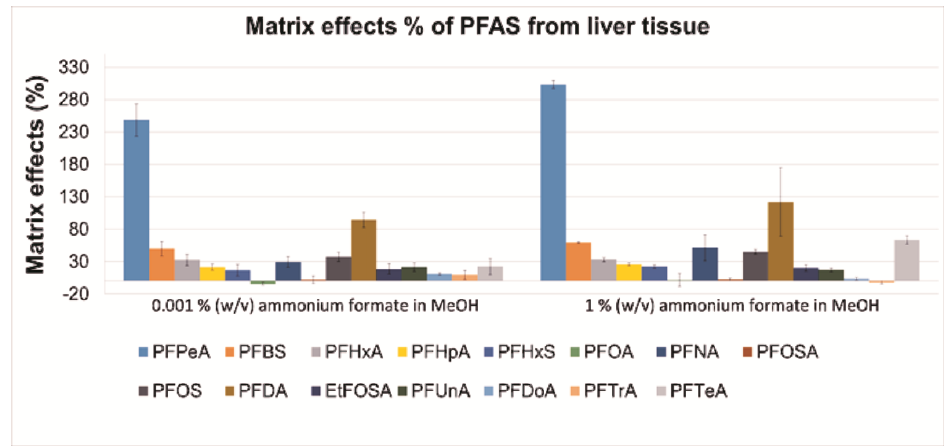
Figure 4. Matrix effects (%; N = 4) at the fortification amount of 10 ng on pooled harbour porpoise liver tissue with two different concentrations of ammonium formate in MeOH.